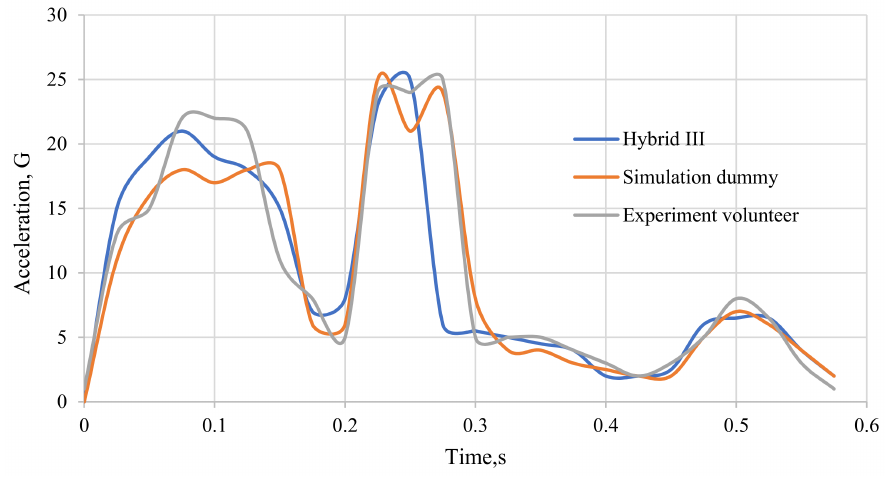
Figure 9. The resultant head